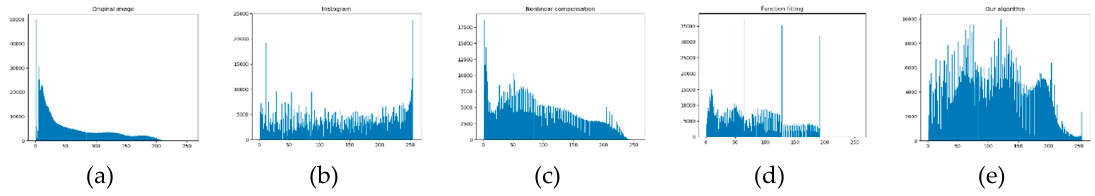
Figure 16. Histograms corresponding to the images in Figure 15: (a) the original side-scan sonar image (b) histogram, (c) non-linear compensation, (d) function fitting, and (e) our method.